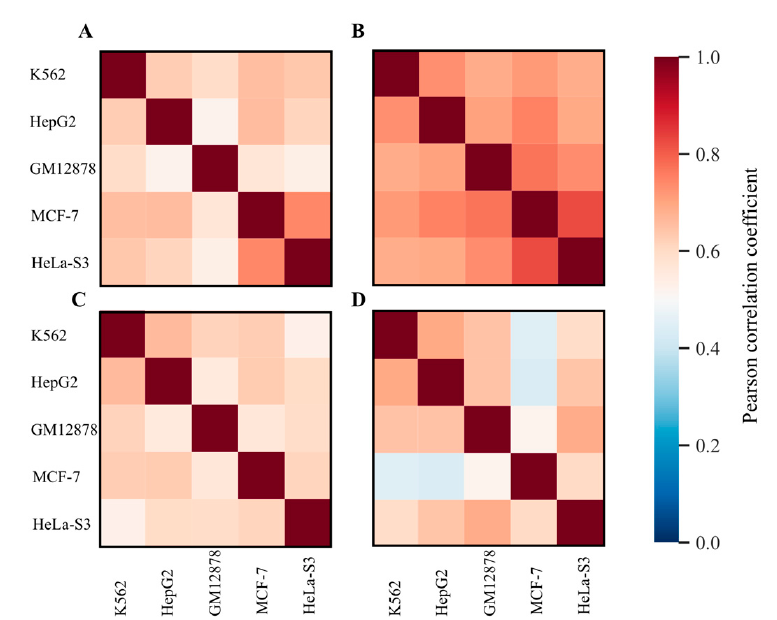
Figure 2. Comparison of RE-linked regulatory enrichment scores between five cell lines investigated. Each panel represents Pearson correlation plot for corresponding score, labels denote cell lines investigated. ( A ) GRE score; ( B ) NGRE score; ( C ) PII score and ( D ) NPII score. Color scale represents Pearson correlation.